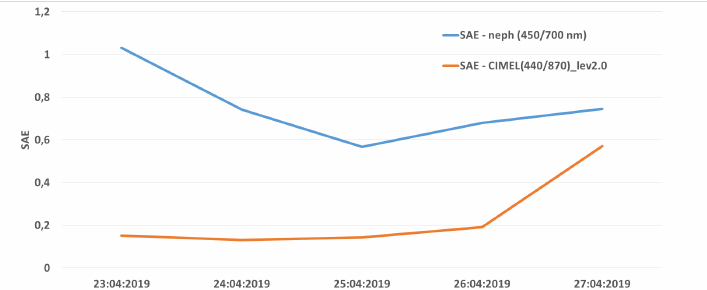
Figure 5. Temporal evolution of mean daily SAE 450,700 measured with nephelometer (blue line) and mean daily SAE 440,870 were obtained by CIMEL (orange line).